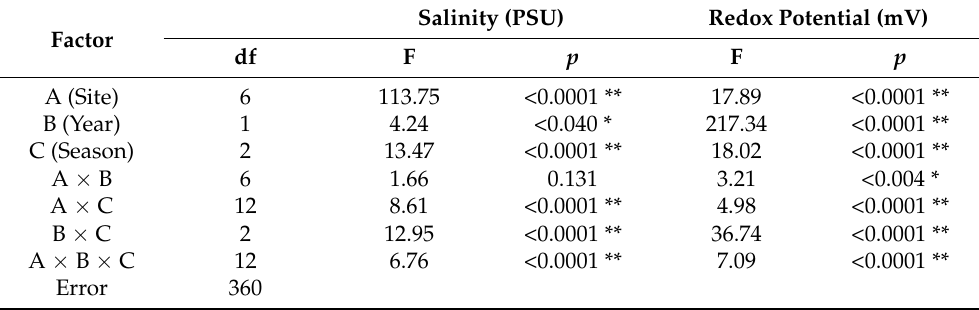
Table 6. Results of a three-factorial repeated-measurement ANOVA on the effects of site (Peten Neyac, R í o Verde, Champot ó n, Sabancuy, Xibuja, Estero Pargo and Atasta), year (2009 and 2010), season (dry, rainy and Nortes) and species ( Rhizophora mangle , Avicennia germinans and Laguncularia racemosa ) on the salinity and redox potential along the Campeche coast, with a significance level of p < 0.05.